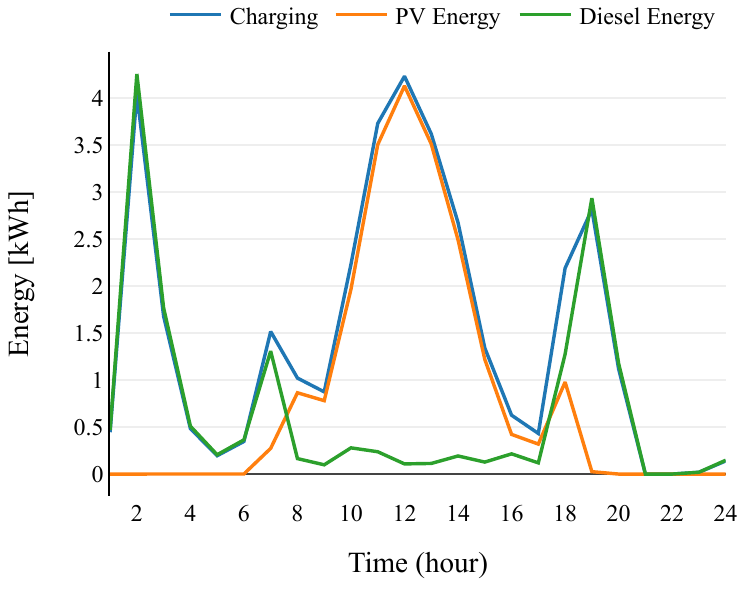
Figure 14. Average energy to charge the BESS for PV-BESS-DG. Figure 15 shows the average SoC of the BESS. For the two given solutions, it is shown that the battery charging process mainly occurs between 7 a.m. and 5 p.m. This is due to the solar resource’s availability for charging. The green and orange lines show that the charging and discharging processes do not occur simultaneously. Figure 15a indicates the hourly average for the whole year. The blue line is the behavior of the SoC during the 24 h. The green line shows the energy used (PV energy + diesel energy) to charge the BESS. The orange line indicates the energy used from the BESS to supply the load. The charging and discharging process meets the maximum energy per hour (Emax). The dashed region denotes the range (in kWh) of the BESS capacity with its maximum and minimum SoC(t), considering the DODmax parameter of the BESS. The process starts when energy is available from the diesel generator and PV Array. Meanwhile, Figure 15b shows that the BESS is only charged when energy is available from the PV array. In Figure 15a,